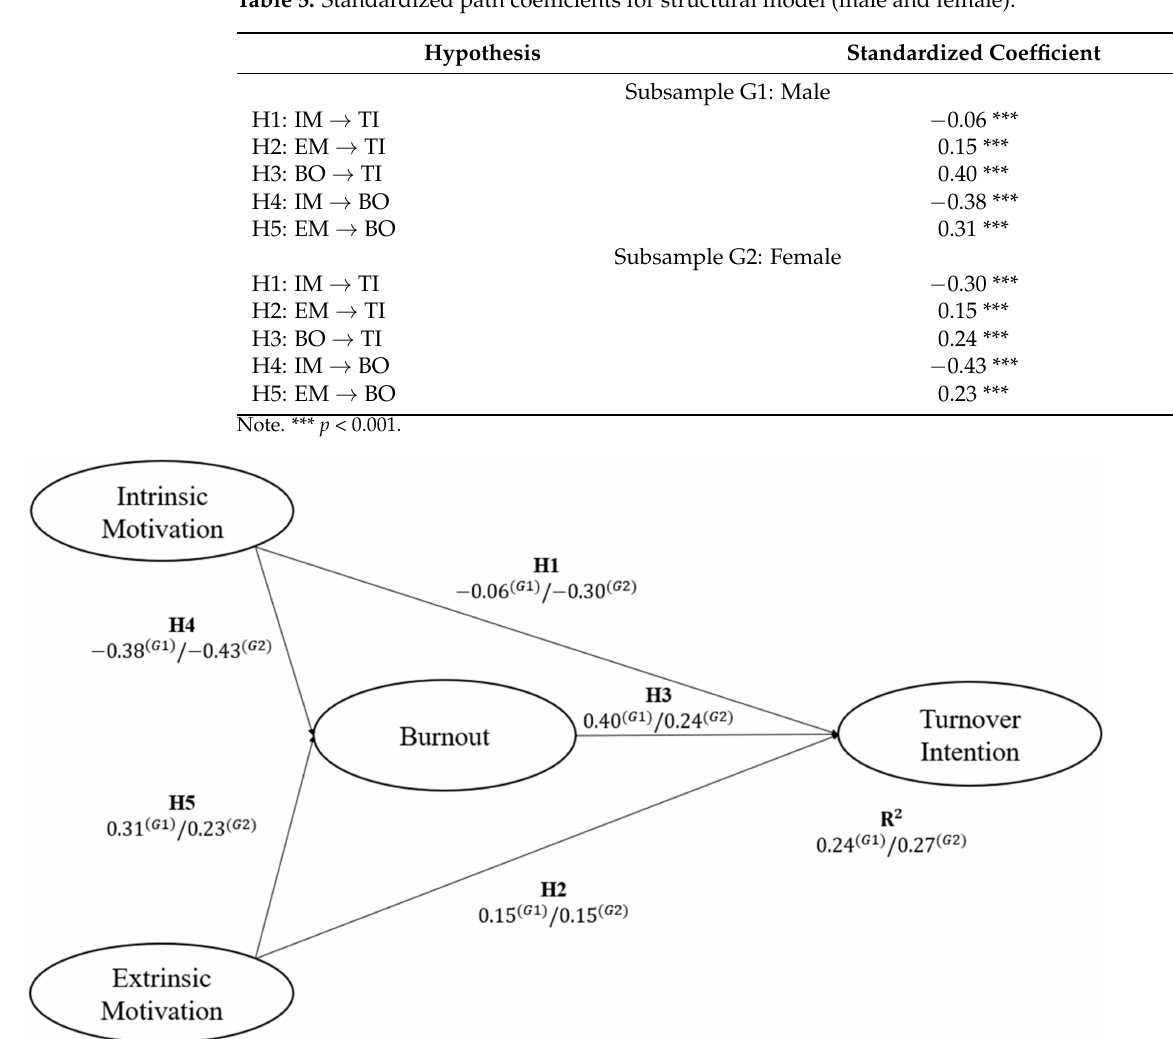
Table 5. Standardized path coefficients for structural model (male and female).